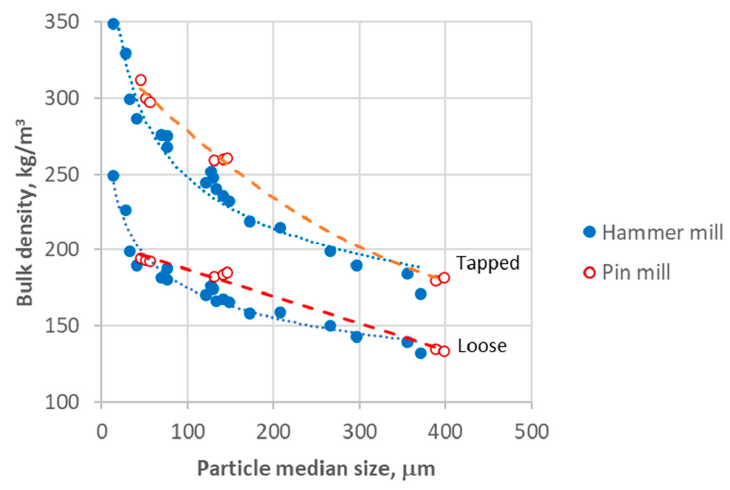
Figure 9. Loose and tapped bulk densities as a function of particle size.